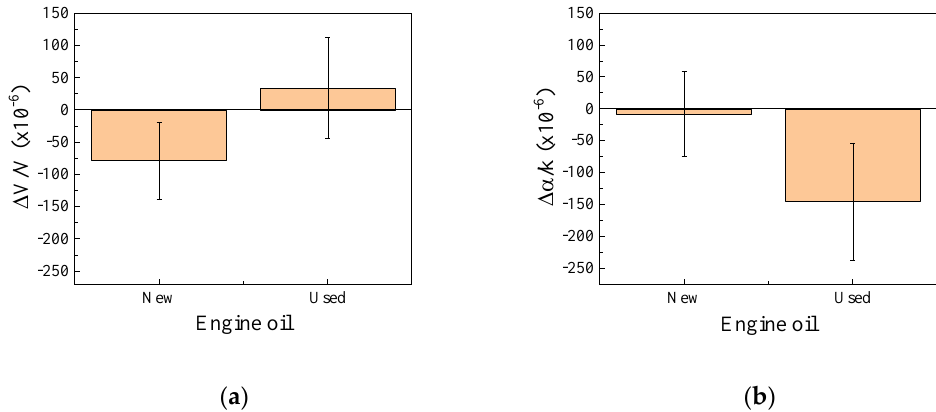
Figure 4. Measured results of new and used engine oils obtained from Ch.1. The reference liquid was the olive oil. ( a ) Velocity change and ( b ) attenuation change.